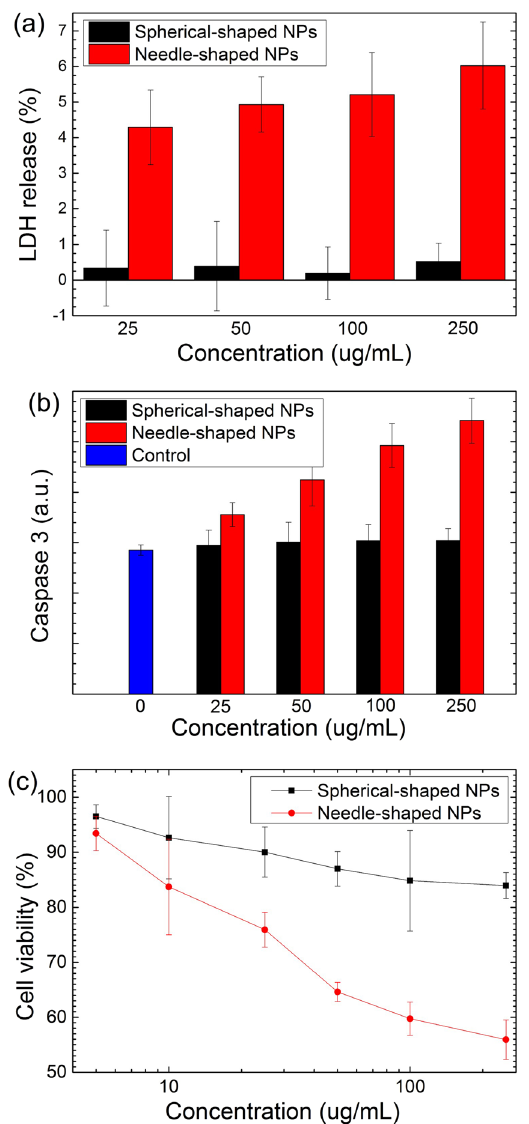
Figure 5. Shape dependent PLGA-PEG NPs’ cytotoxicity. ( a ) LDH release (normalized to lysed control cell), ( b ) Caspase 3 activity and ( c ) MTT assay after HepG2 cells were fed with spherical- and needle-shaped PLGA- PEG